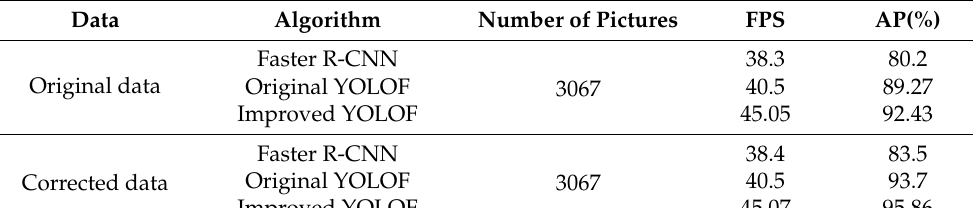
Figure 5. Loss of the detection networks. Table 2. Comparison of detection results between the original YOLOF and improved YOLOF.